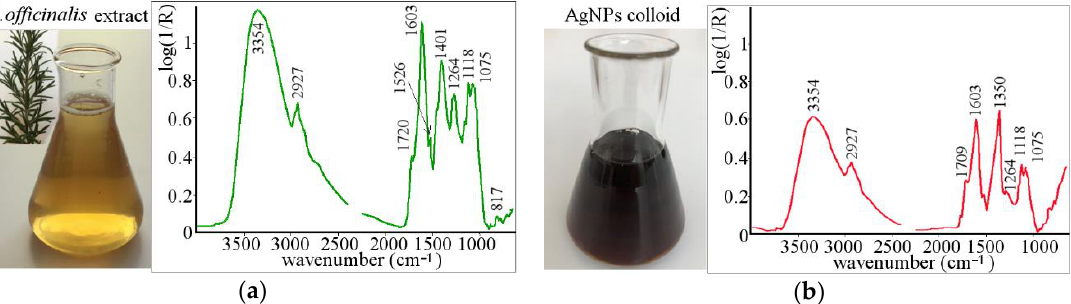
Figure 1. Rosmarinus officinalis leaves extracts and the FTIR analysis of the extract before AgNPs synthesis ( a ); the AgNPs colloidal solution and the FTIR analysis of AgNPs colloid (after nanoparticles synthesis) ( b ).